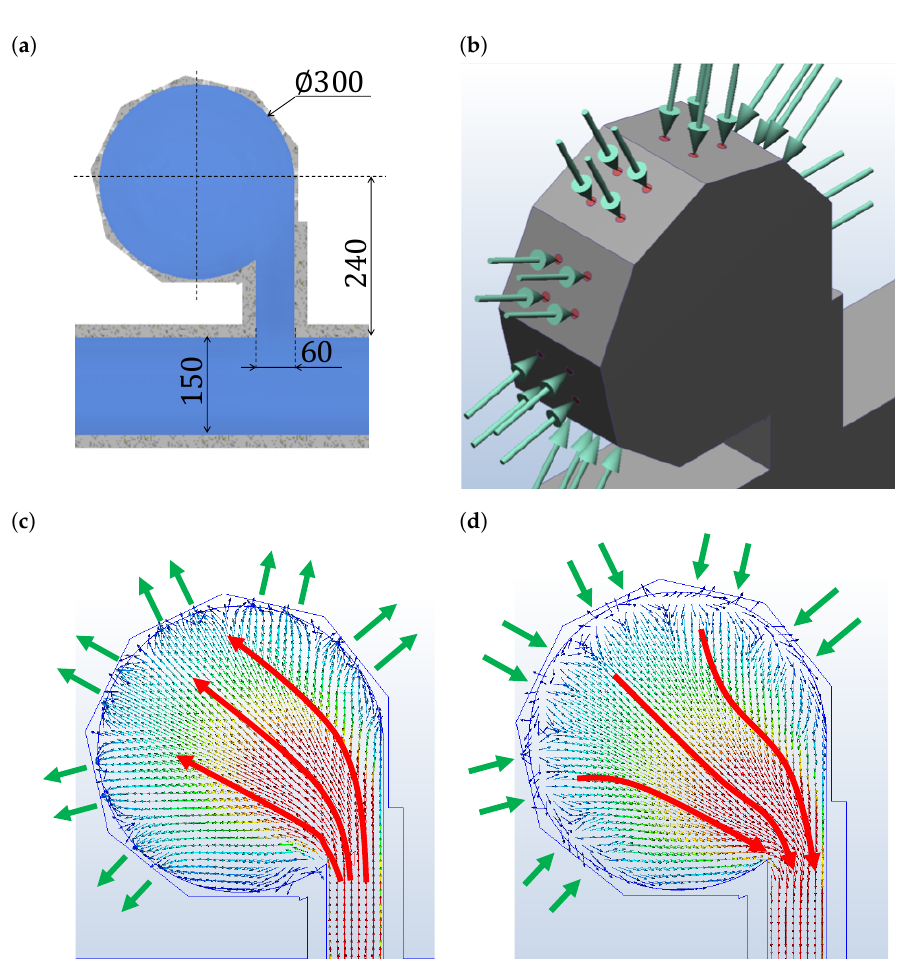
Figure 3. Simulation results. ( a ) Main chamber model. Because the surface to which pressure is applied must be flat, the outer shape was polygonal. ( b ) How to apply pressure to the main chamber. Since it was not possible to simulate the change in flow owing to the deformation of the wall, it was assumed that pressure is applied. ( c , d ) Streamlines during expansion and contraction. Streamlines were different between expansion and contraction; therefore, the net vortex was created by repeating this